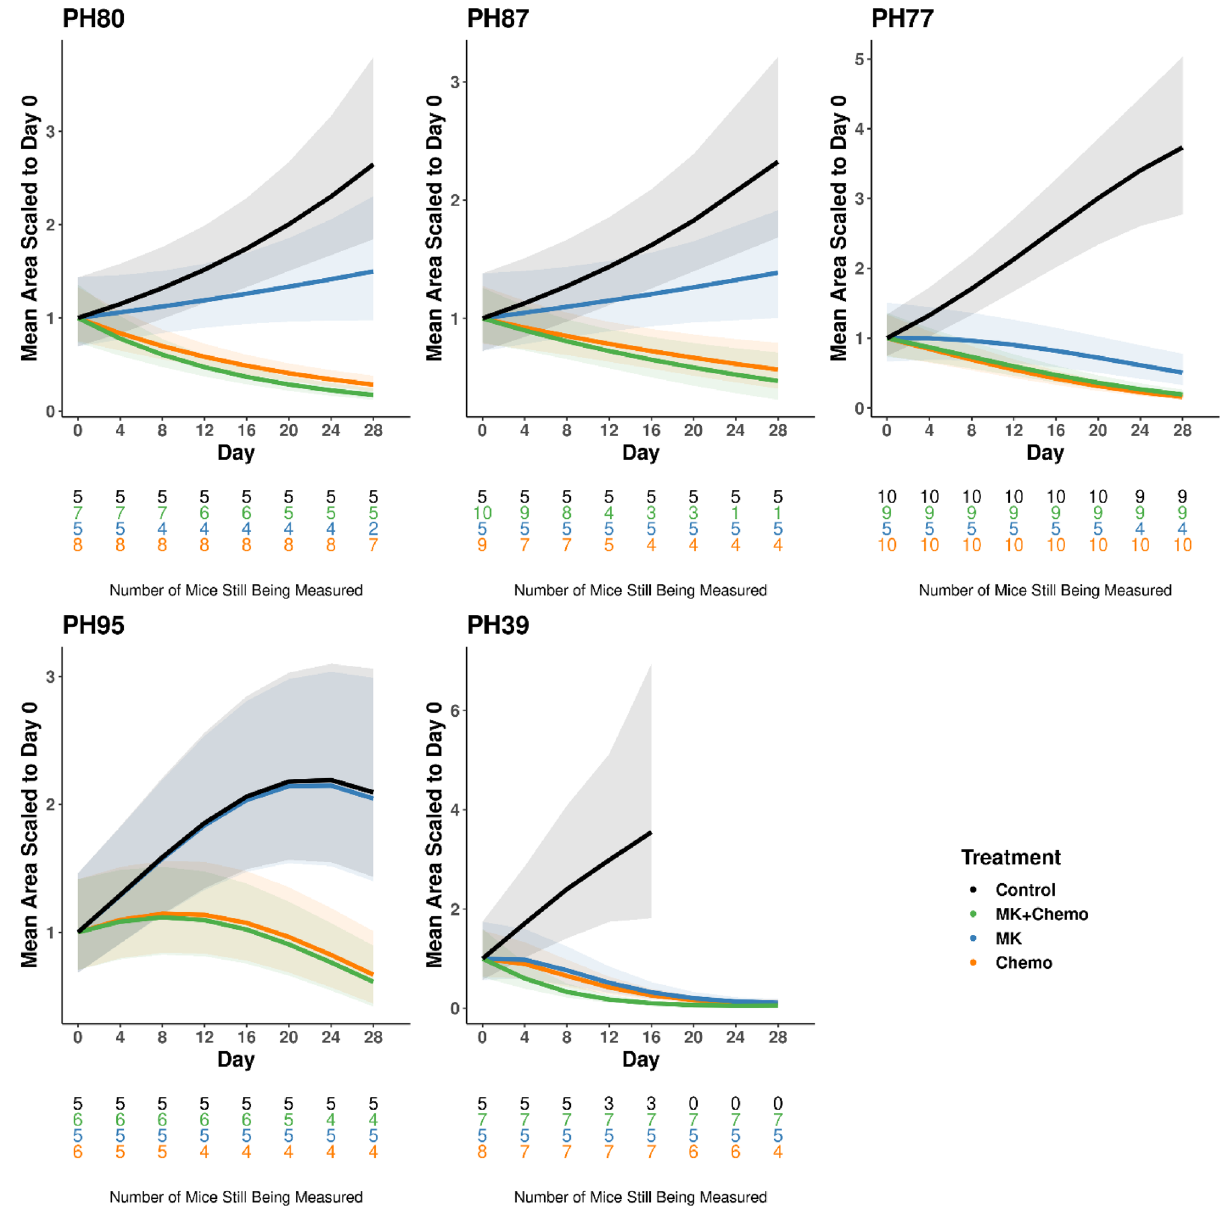
Figure 3. Model estimates of growth trajectories for each PDX model. Coloring indicates drug arm. Predicted lines are the average estimates computed from the statistical model fixed effects, relative to the arm specific baseline estimate. The forms of the statistical mean models are the following: PH80, PH87: straight; PH77, PH95: quadratic; PH39: cubic. Shading indicates 95% confidence intervals. The number of mice under observation at each time point for each arm is indicated below the x-axis as a function of time, where text color indicates drug